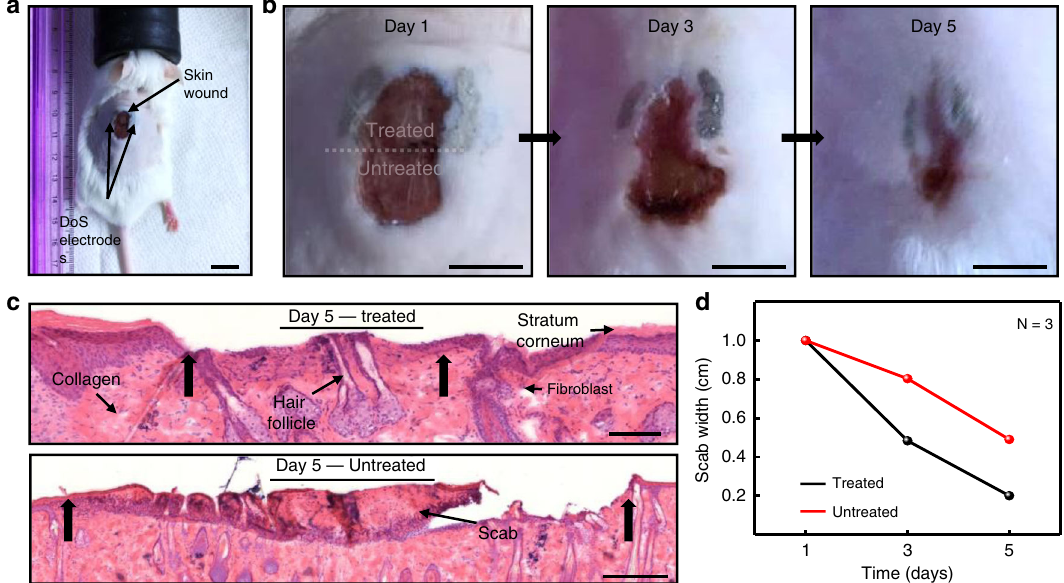
Fig. 6 Accelerated skin wound healing with DoS electronics. a Experimental setup showing DoS electrodes around a skin wound on the back of mice ( N = 3). The DoS electrodes served as conductive paths for electrical stimulation (scale bar 2 cm). b Photos of the wound healing on day 1 (left), day 3 (middle) and day 5 (right). Top half of the wound was treated with electrical stimulation while the bottom half was left untreated and healed naturally (scale bar 1 cm). c Histology images of the treated (top, scale bar 100 µ m) and untreated (bottom, scale bar 250 µ m) halves of the wound on day 5. The black arrows indicate the width of the wound. d Scab width over time for the treated (black) and untreated (red) halves of the